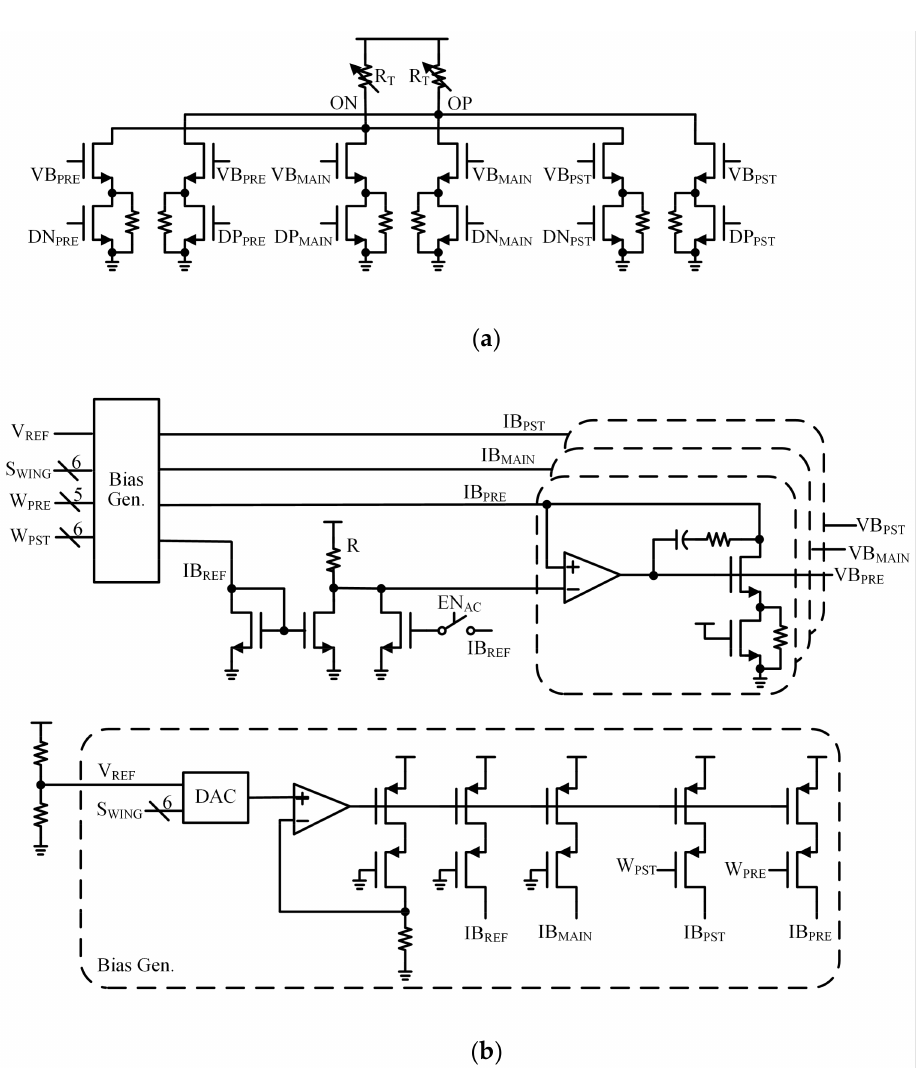
Figure 4. ( a ) The proposed CML-based output driver with a 3-tap FFE. ( b )The details circuit of the bias